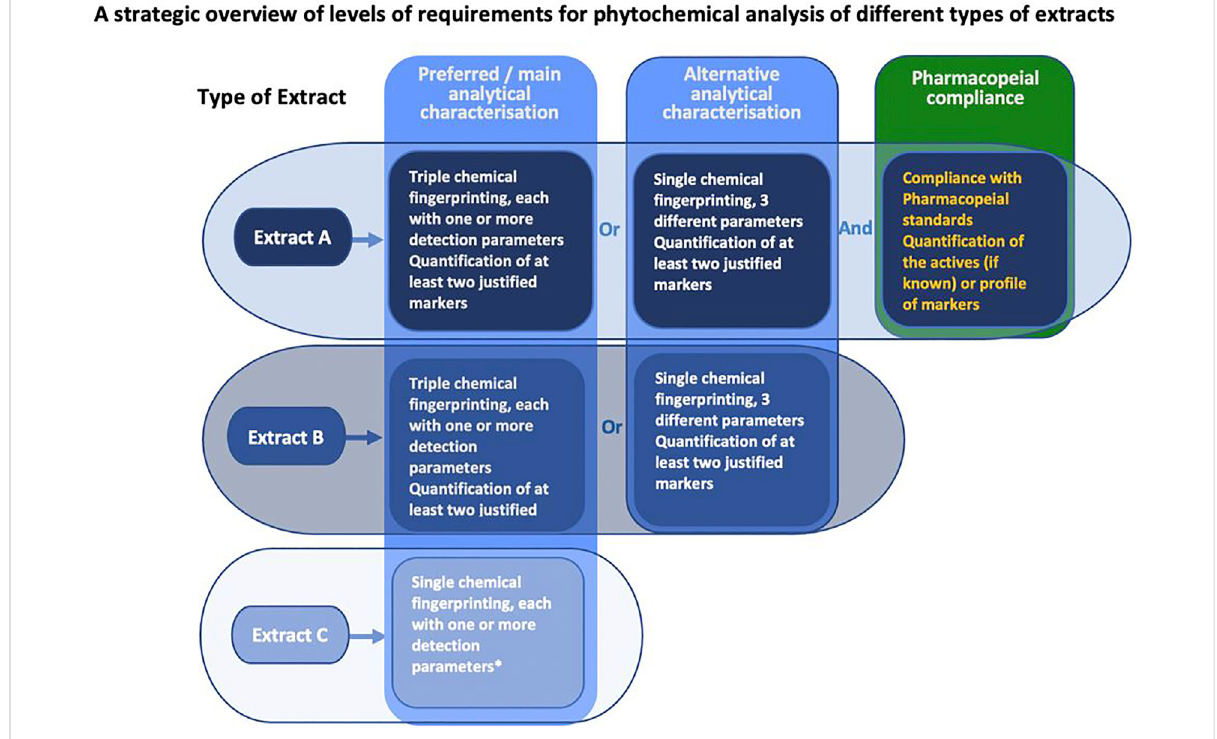
FIGURE 7 Different requirement levels for phytochemical characterisation of different extract types — a simpli fi ed overview (see Table 4 for detailed requirements of the preferred methods in extract characterisation/phytochemical analysis with their speci fi cations) *No description of marker substances is needed but may be